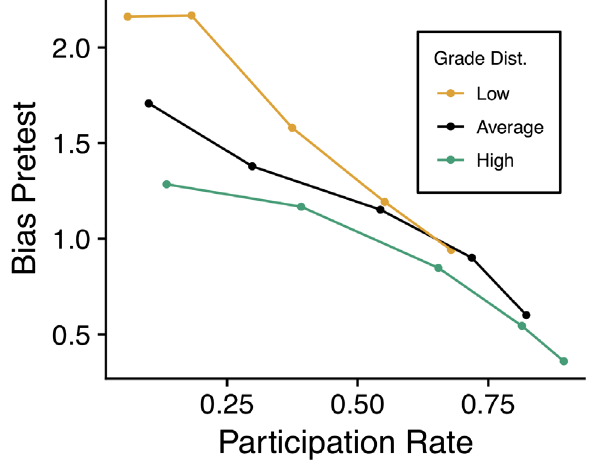
FIG. 9. Bias in the pretest model for the three grade distribu- tions. Only the bias for the complete-case analysis is presented because no data were missing for the pretest and therefore the MI estimates could not be biased.